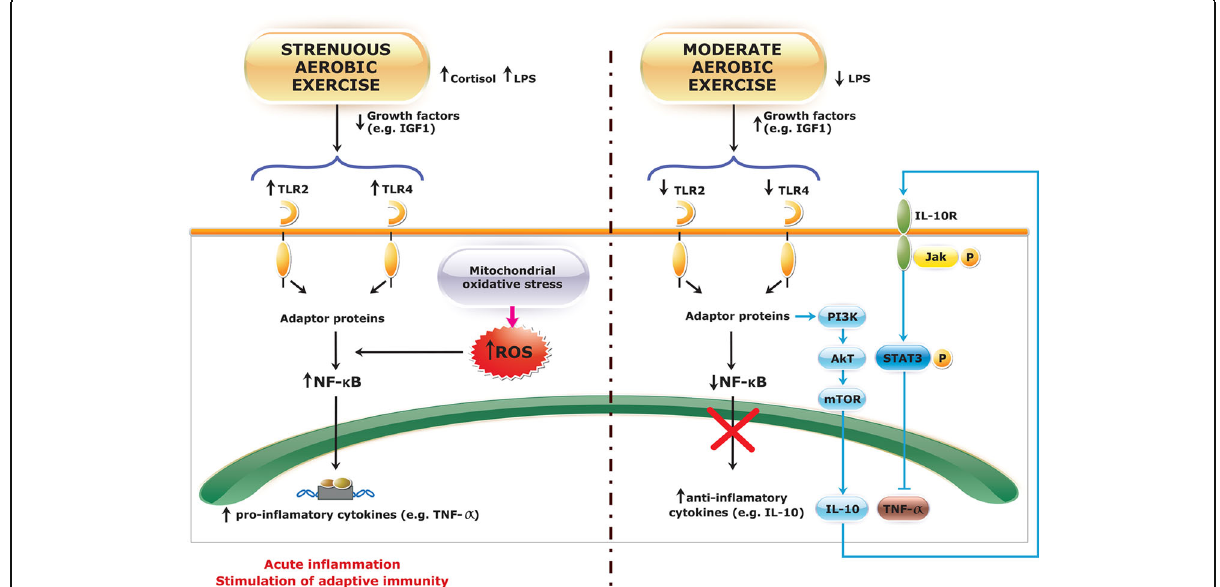
Fig. 1 Signaling involving TLR2 and TLR4 in strenuous and moderate aerobic exercise. Excess physical exercise increases LPS levels and contributes to TLR2, TLR4, and NF-kB upregulation. As a consequence, there is an increase in circulating pro-inflammatory cytokines. Stimuli of exercise stress transmit nerve impulses to the brain, raising the levels of counter-regulatory hormones such as cortisol. Accordingly, high mitochondrial oxidative stress induced by strenuous aerobic exercise causes excessive intracellular ROS formation that also upregulates NF-kB expression, intensifying the acute inflammation state. Under these excessive stress conditions, adaptive immunity can be triggered by the increase in costimulatory molecules in antigen-presenting cells, thus activating T cells. In contrast, the regular physical exercise of moderate intensity reduces LPS, TLR2, TLR4, and NF-kB expression. Under these conditions, NF-kB does not translocate to the cell nucleus. Instead, the anti-inflammatory pathway PI3K/AKT/mTOR is activated, promoting the production of anti-inflammatory cytokines such as IL-10 that inactivate TNF- α . Physical exercise at a moderate intensity also has a compensatory effect against the exacer- bated production of reactive oxygen and nitrogen species responsible for the oxidative damage. Elevated production of IGF-1 is observed after exercise. IGF-1 provides an anti-inflammatory effect on the skeletal muscle cells, reducing the expression of the pro-inflammatory cytokines through a decrease of TLR4